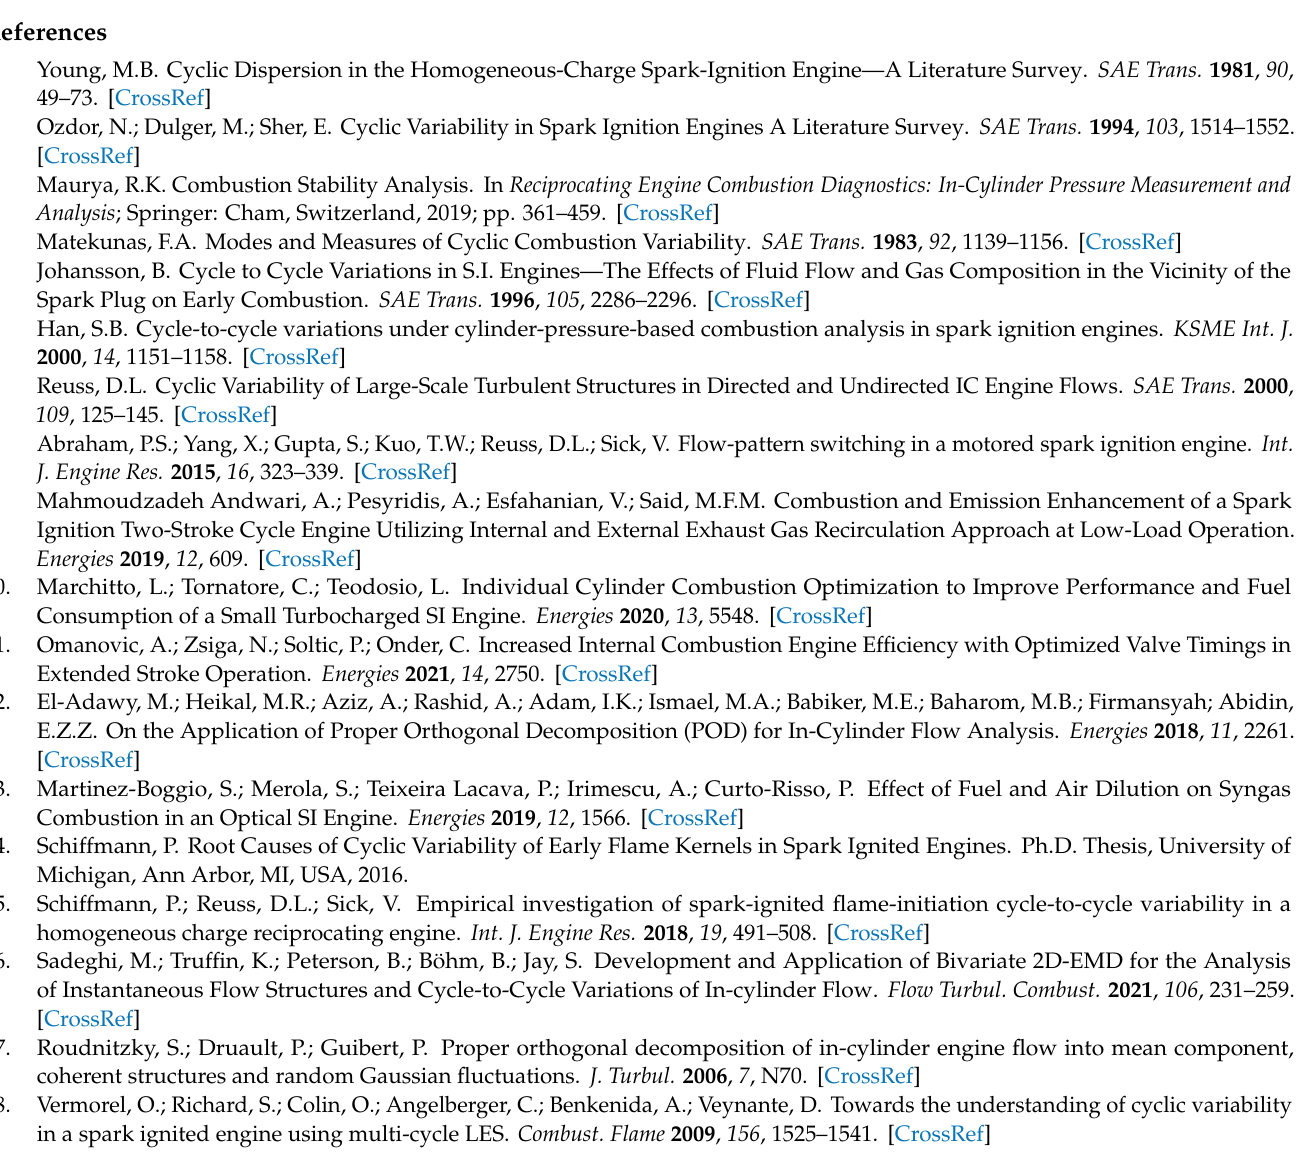
Figure A2. In-cylinder results for cycle 8 and restart of cycle